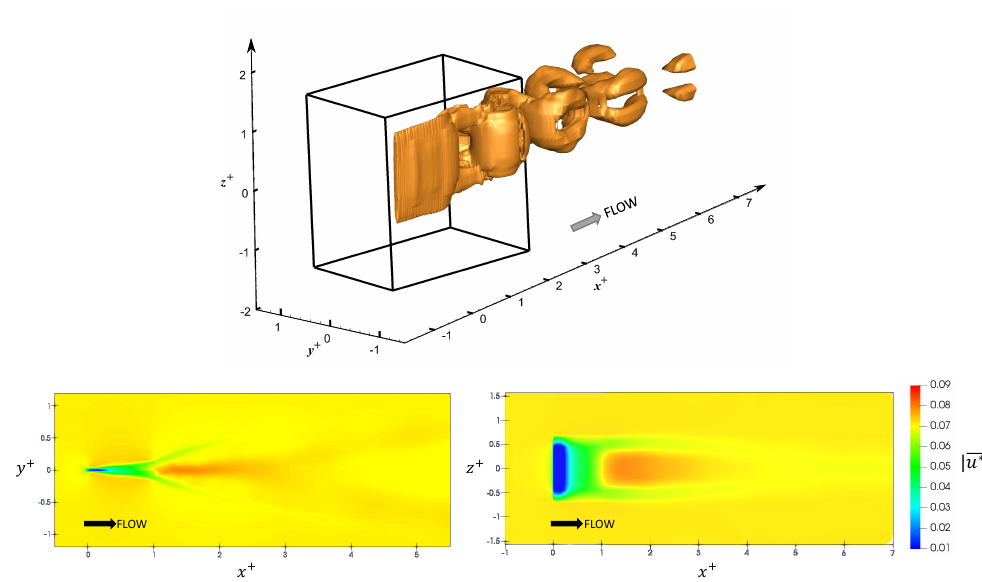
Figure 14. Three dimensional isometric view of iso-surfaces corresponding to | ω ∗ | = 1 (top). Black edges depict the overset grid boundaries. Bottom figures depict two-dimensional Iso-contours for time averaged velocity magnitude | u ∗ | . The Reynolds number is